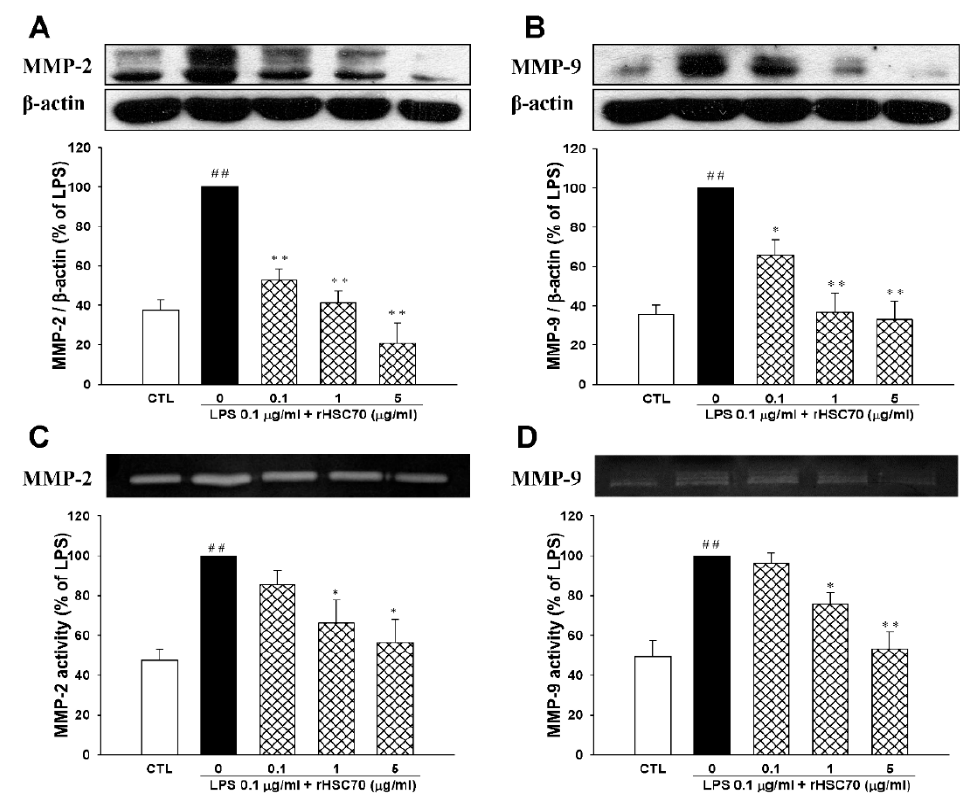
Figure 4. Effects of rHSC70 on LPS-induced activations of MMP-2 and MMP-9. RAW264.7 cells were pretreated with rHSC70 (0.1, 1 and 5 µ g/mL) for 5 min before LPS treatment and protein samples were prepared 24 h after LPS treatment. ( A , B ) Effects on protein expressions of MMP-2 and MMP-9 were analyzed by western blotting. ( C , D ) Effects on activities of MMP-2 and MMP-9 were analyzed by gelatin zymography. Recombinant HSC70 inhibited LPS-induced MMP-2/-9 protein